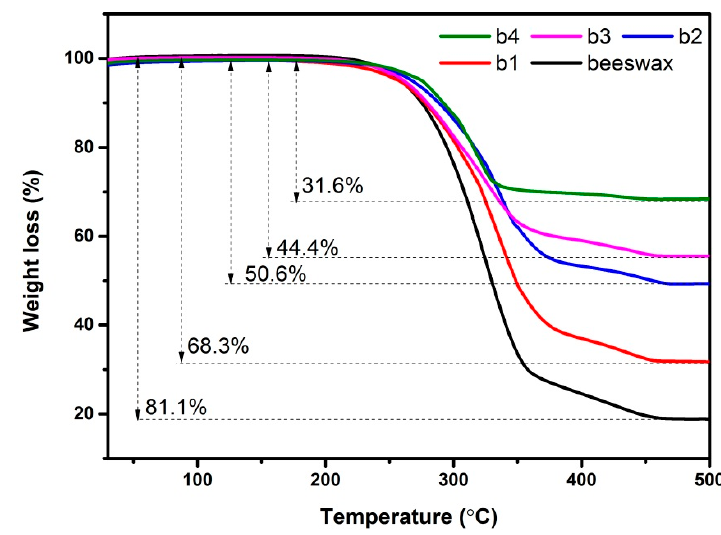
Figure 10. TG curves for the beeswax and beeswax/AgBr microcapsules.